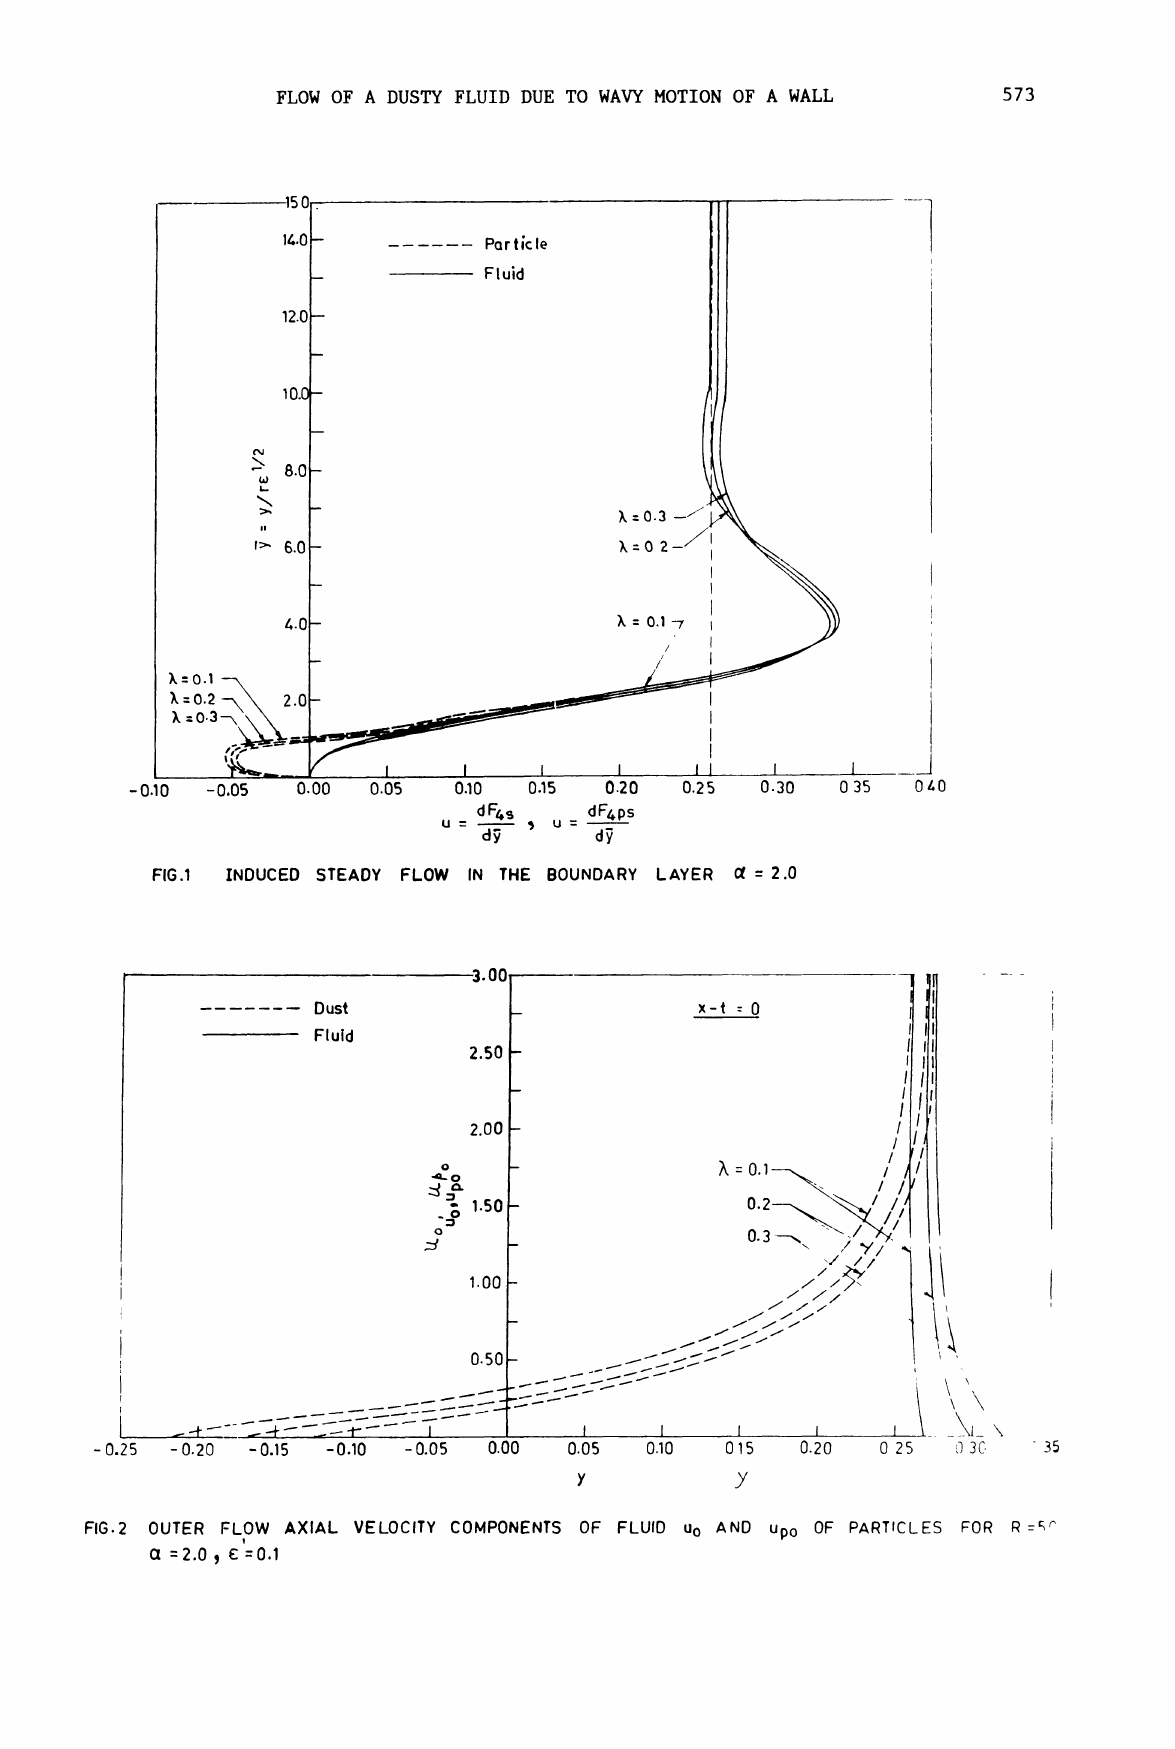
FIG.2 OUTER FLOW AXIAL VELOCITY COMPONENTS OF FLUID Uo AND Upo OF PARTICLES FOR R= Cl =2.0